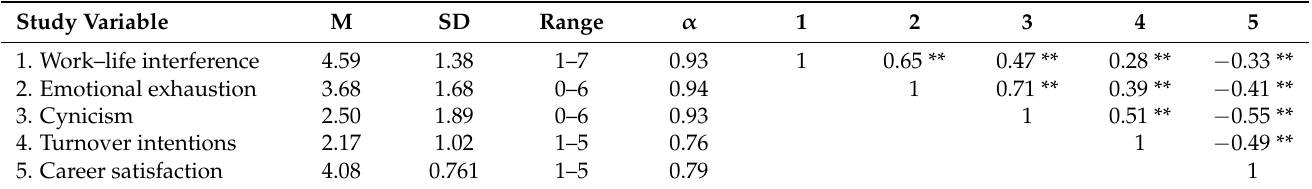
Table 2. Correlations, means, standard deviations, and reliabilities of the major study variables.